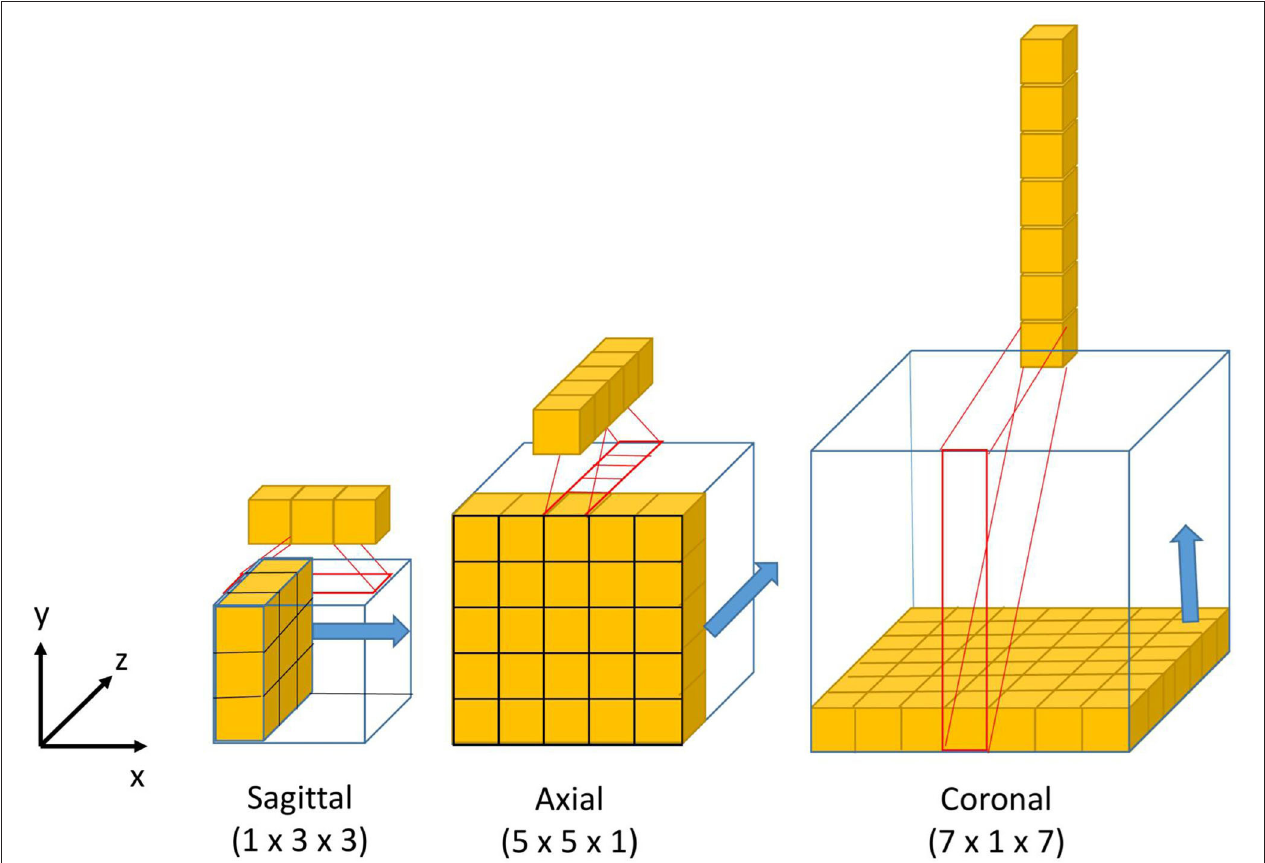
FIGURE 2 | Visual representation of the 3D anisotropic kernels inside each branch of the 2.5D Multi-View Inception block.